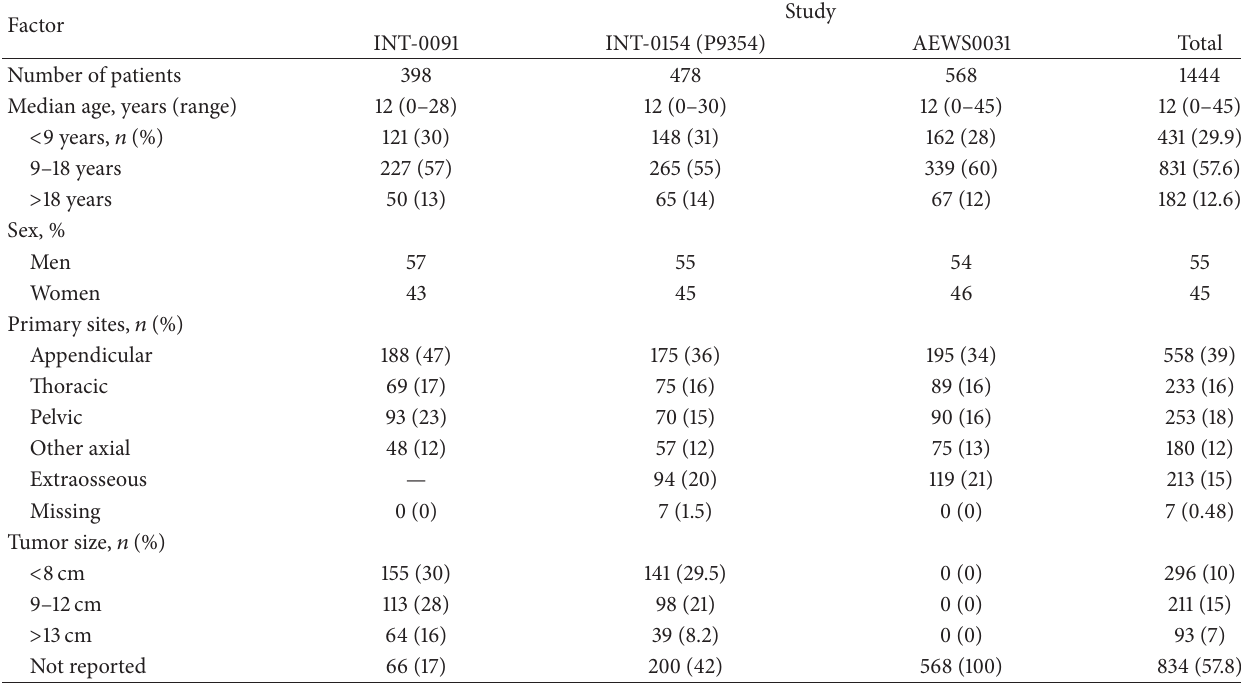
Table 1: Characteristics of 1444 patients enrolled in COG studies.